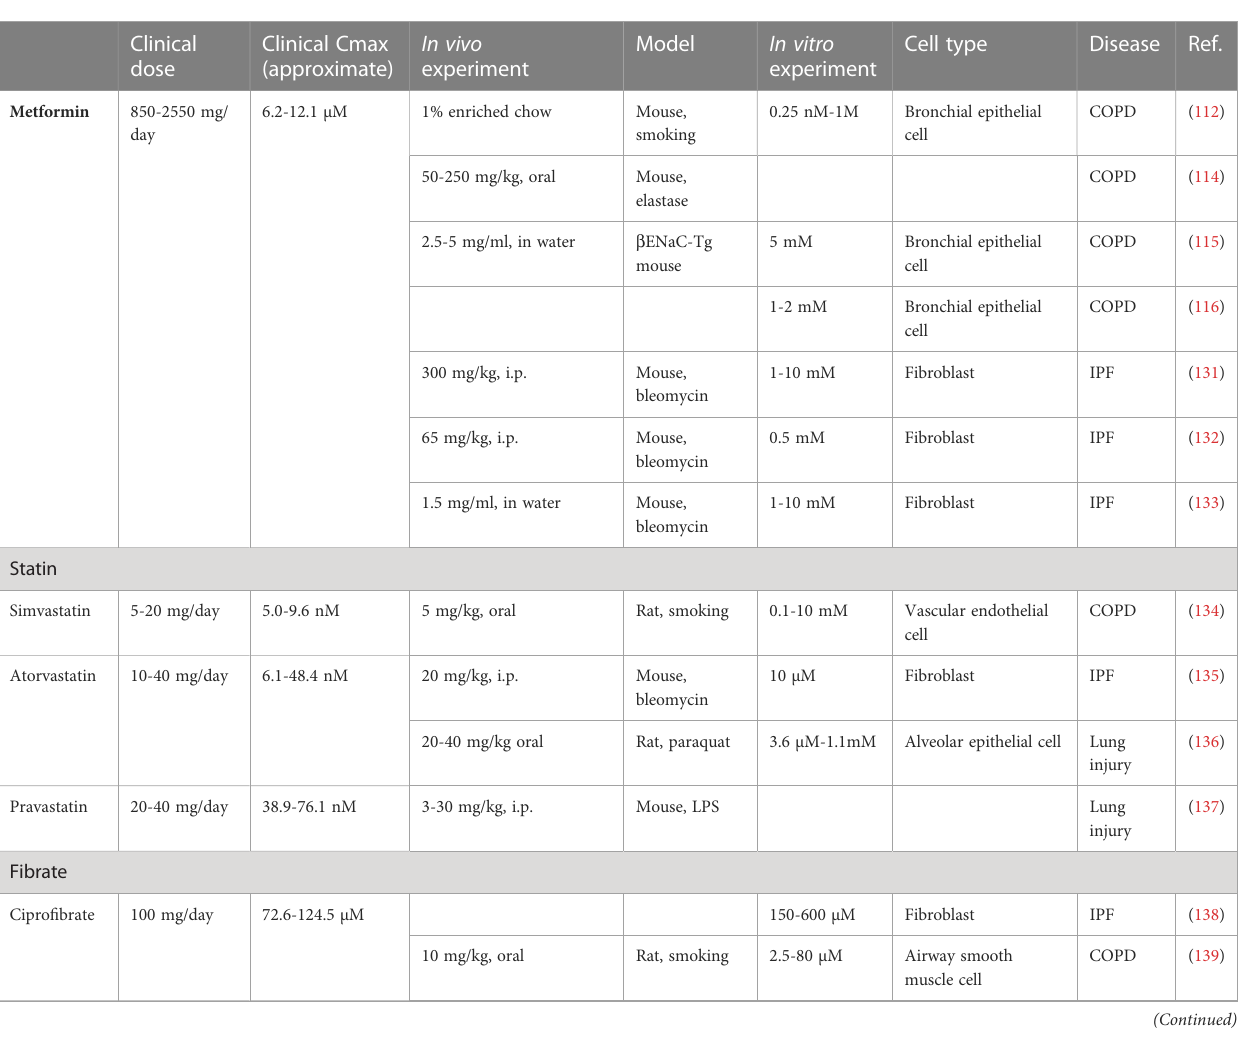
TABLE 2 Concentration of drugs against metabolic diseases in clinical and experimental setting. In vivo Clinical Clinical Cmax dose (approximate) experiment